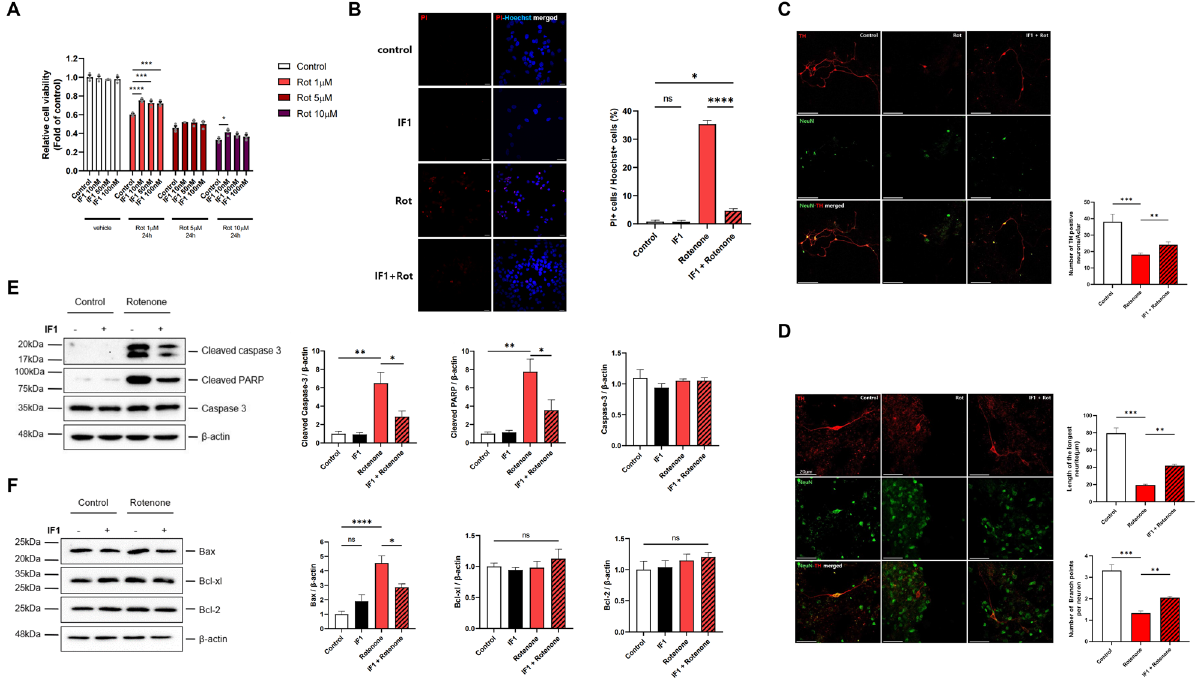
Figure 3. Treatment with IF1 protects dopaminergic cells from PD-like neurotoxicity and prevents rotenone- induced apoptosis in SH-SY5Y cells. (A ) SH-SY5Y cells were treated with rotenone (1, 5, and 10 µM) with or without a specific concentration of IF1 (10, 50, and 100 nM). After 24 h incubation, cell viability was evaluated by MTT assay. ( B ) SH-SY5Y cells were treated with 1 µM rotenone, 100 nM IF1, or a combination of both for 24 h. Representative images of propidium iodide (PI) staining results. Red: PI; Blue: Hoechst, Scale bar = 20 µm (left panel). A bar graph indicates the number of PI positive cells normalized to Hoechst in each group (right panel). ( C ) Mouse primary dopaminergic neurons were treated with 1 µM rotenone with or without 10 nM IF1 for 16 h and simultaneously immunostained for tyrosine hydroxylase (TH) and Neun (Neuronal marker). The number of TH-positive cells was observed (upper panel), quantified, and presented as a bar graph (lower panel). Scale bar = 100 μm. ( D ) The average length of longest neurites and the number of branches per neurites of TH positive cells were observed (upper panel), quantified, and presented as a bar graph (lower panel). Scale bar corresponds to 50 μm. One-way ANOVA with a Tukey’s post-hoc analysis. ( E,F) SH-SY5Y cells were treated with 1 µM rotenone, 100 nM IF1, or a combination of both for 24 h. ( E) The abundance of protein levels of cleaved caspase-3, cleaved PARP, and full-length caspase-3 were analyzed using immunoblotting (left panel) and quantified (right panel). ( F ) Protein levels of Bcl-2 family (Bax, Bcl-xL, and Bcl-2) were analyzed using immunoblotting (left panel) and quantified (right panel). All protein levels were normalized to β-actin and presented as a bar graph. (E,F) Membranes were cut to enable blotting for multiple antibodies and the full- length blots are presented in Supplementary information file. Data are expressed as mean ± SEM, n = 3. *p < 0.05, **p < 0.01, ***p < 0.001, ****p < 0.0001. ns not significant. One-way ANOVA with a Tukey’s post-hoc